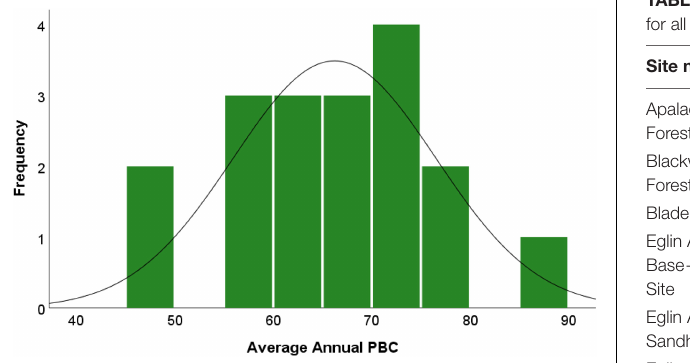
FIGURE 2 | Frequency histogram of average annual percent of trees bearing cones per site ( n = 18, µ = 78%, SD = 10%).